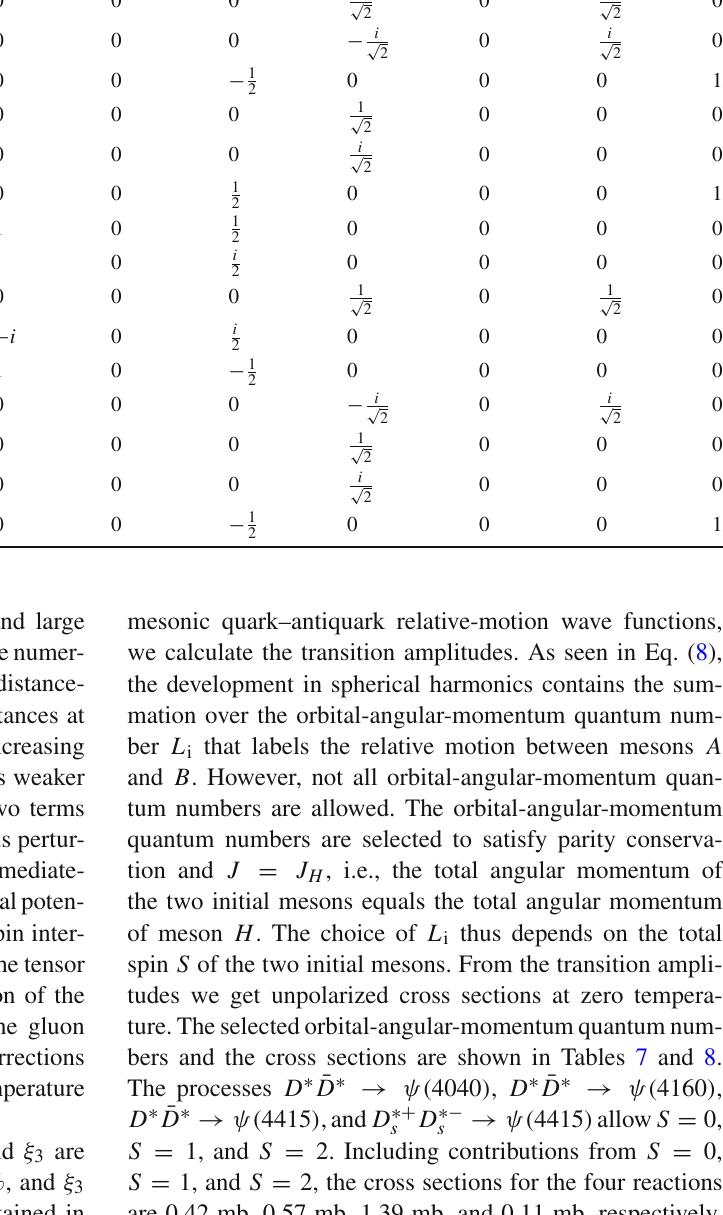
Table 6 Spin matrix elements in M r q S